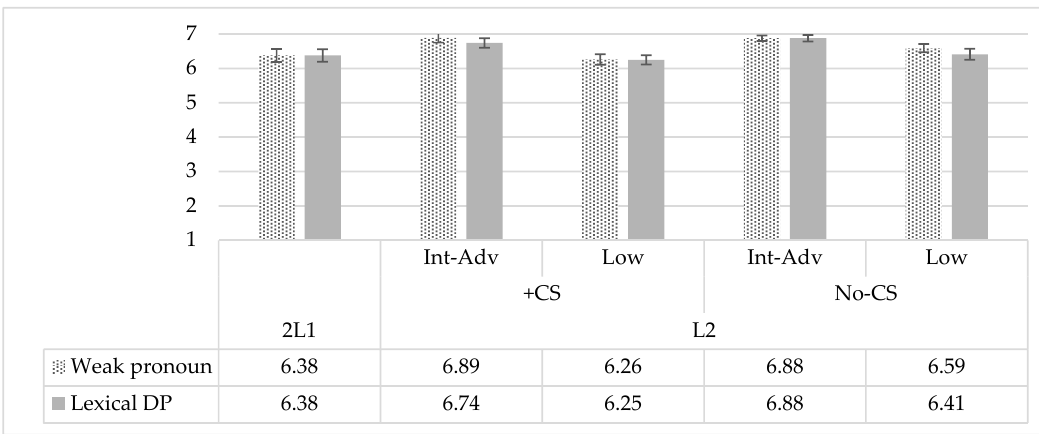
Figure 8. Code-switched subject stimuli ratings by group and type. Figure 9. Code-switched English-to-Spanish subject stimuli ratings by group and type.